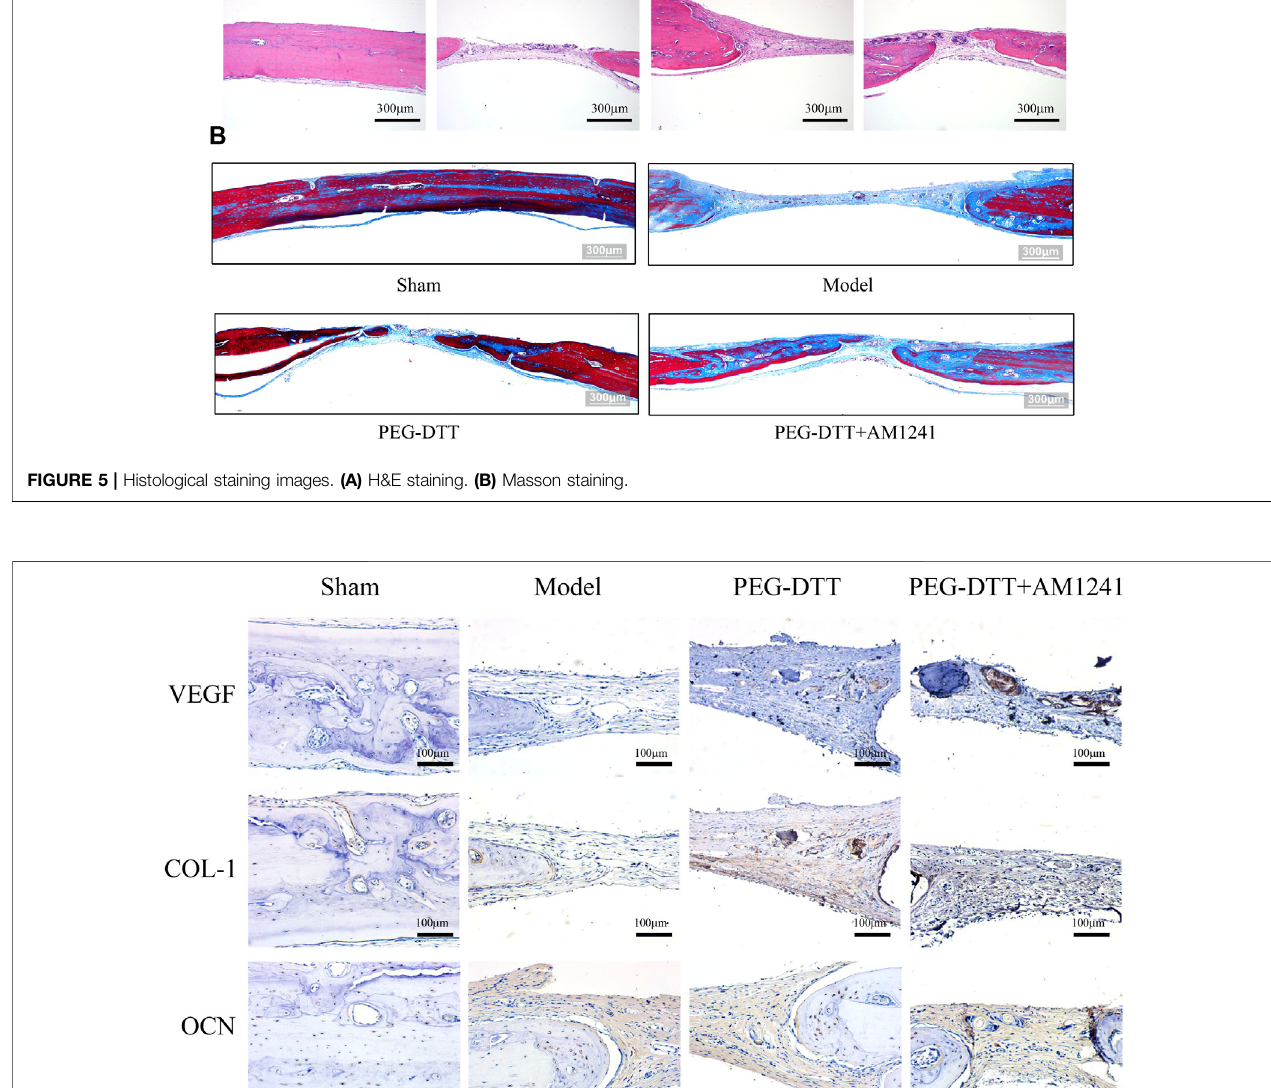
Frontiers in Cell and Developmental Biology |